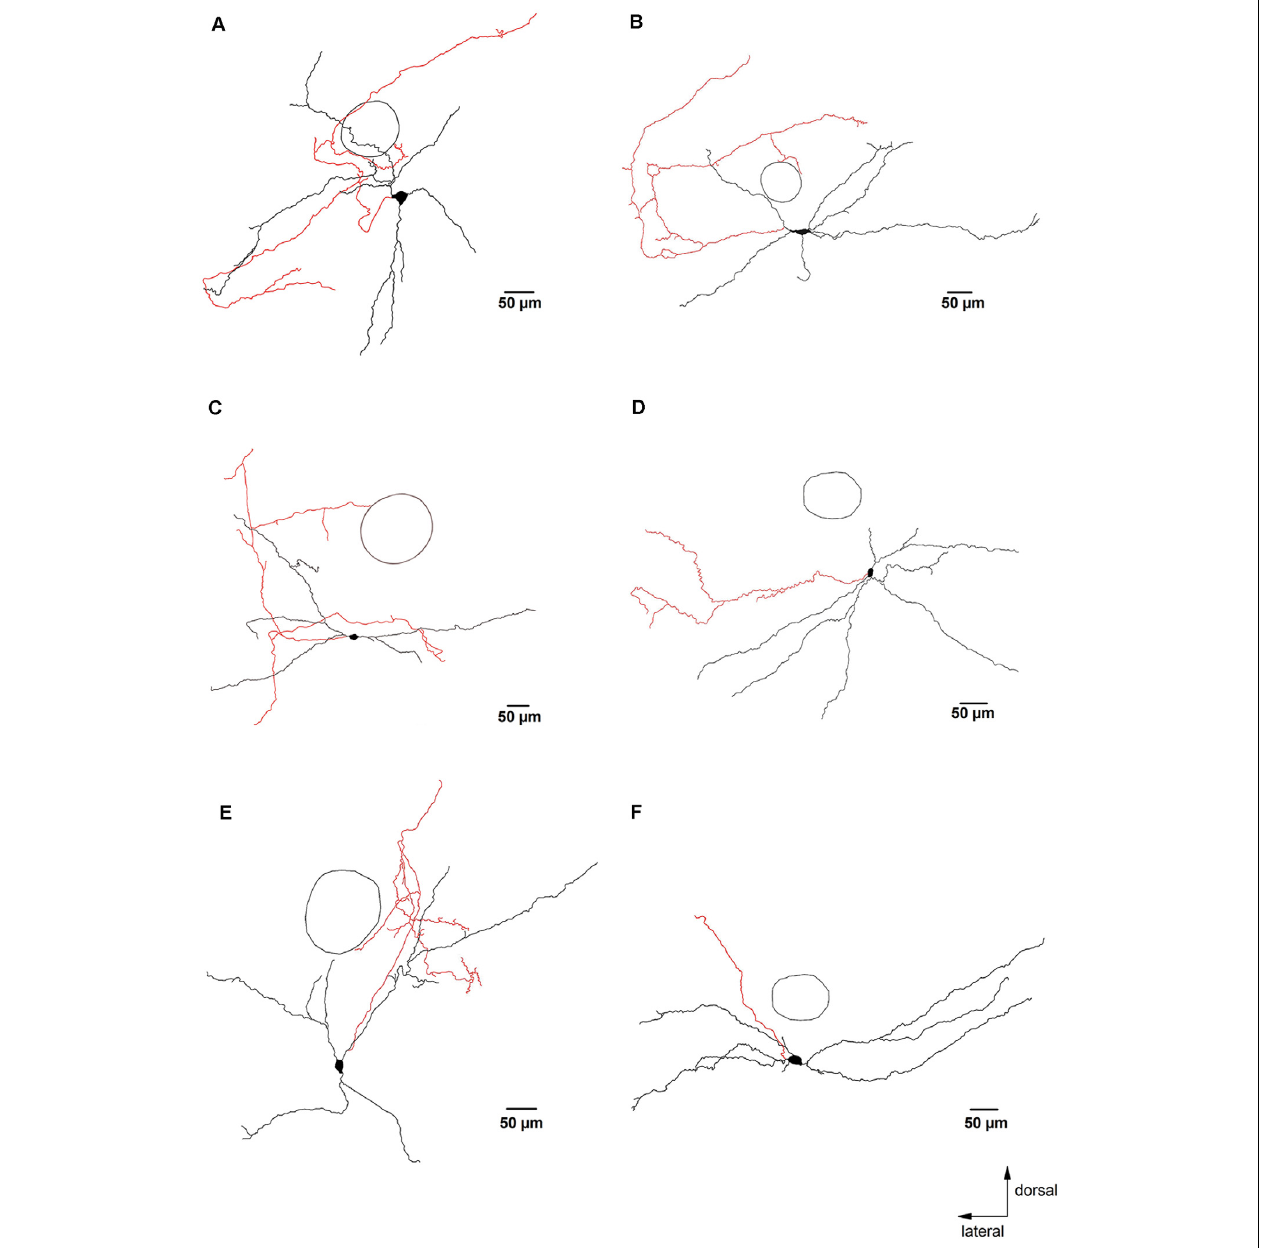
FIGURE 3 | Glycinergic neurons with axons that remained close to the preBötC. Panels (A–F) are examples of camera lucida drawings of biocytin-labeled glycinergic neurons in the preBötC. These neurons had axons and axon collaterals that remained mostly within 500 µ m from the soma. The circle indicates the location of NA as an orientation reference. The axons are depicted in